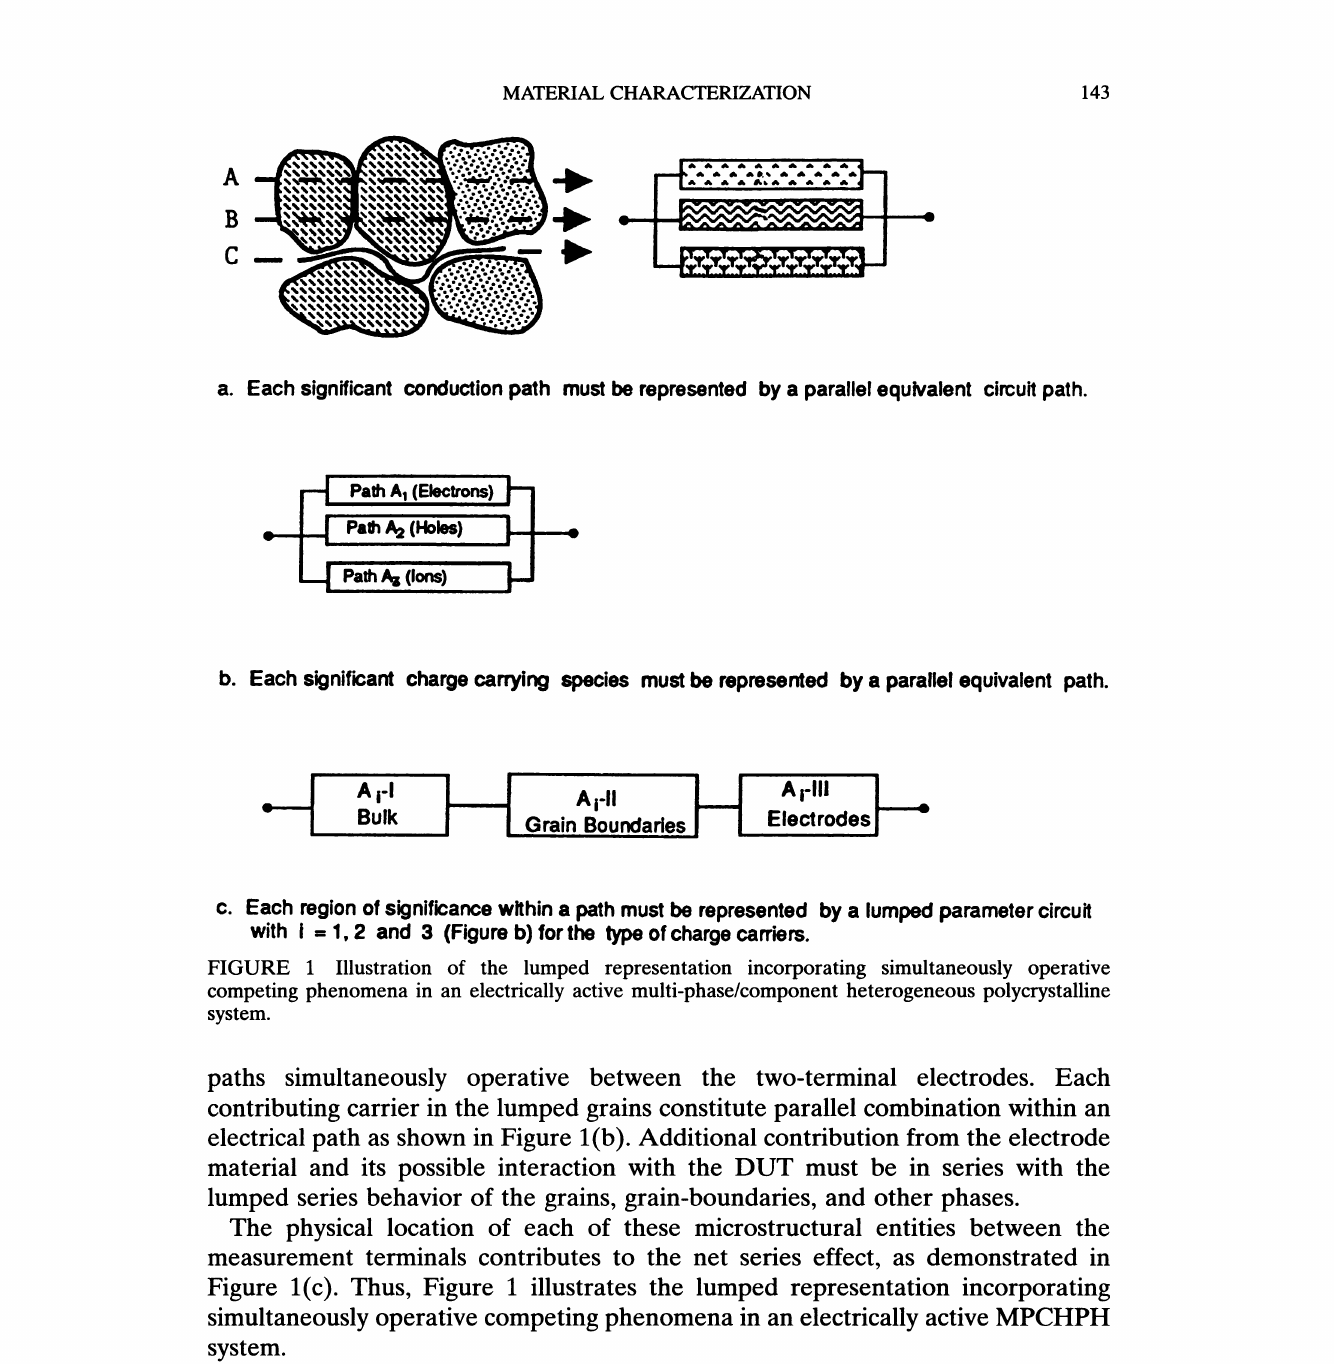
FIGURE 1 Illustration of the lumped representation incorporating simultaneously operative competing phenomena in an electrically active multi-phase/component heterogeneous polycrystalline